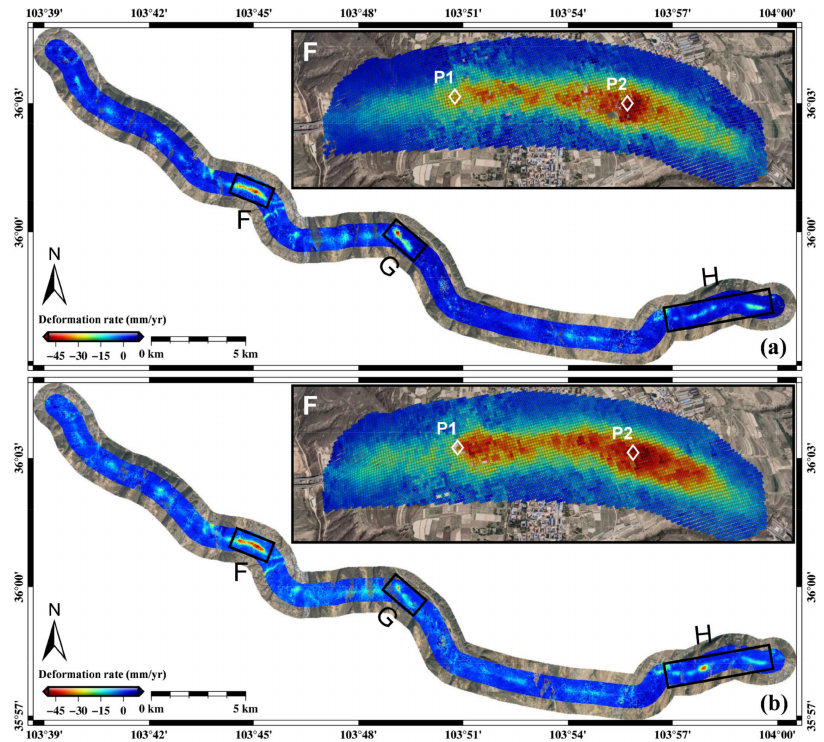
Figure 13. Annual displacement rates along the Lanzhou Belt Highway (LBH) from December 2015 to December 2017 calculated with ascending ( a ) and descending ( b ) Sentinel-1 images. Regions F, G and H, marked by black rectangles, are the three areas with larger displacement rates along the LBH, and Points P1 and P2 are used to show the displacement time